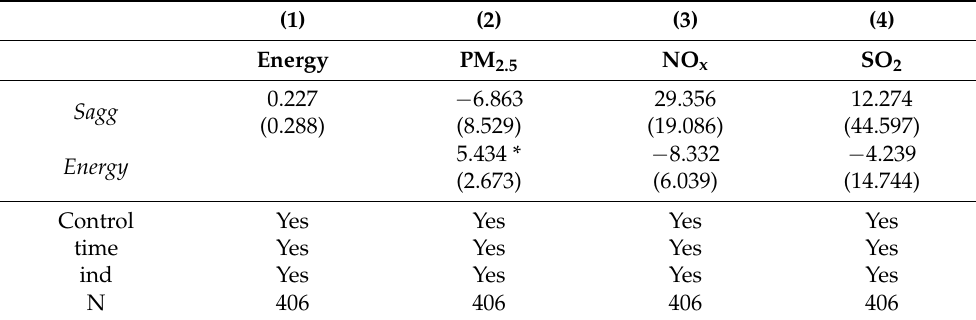
Table 13. Test of the mediating role of energy consumption structure in the agglomeration of producer